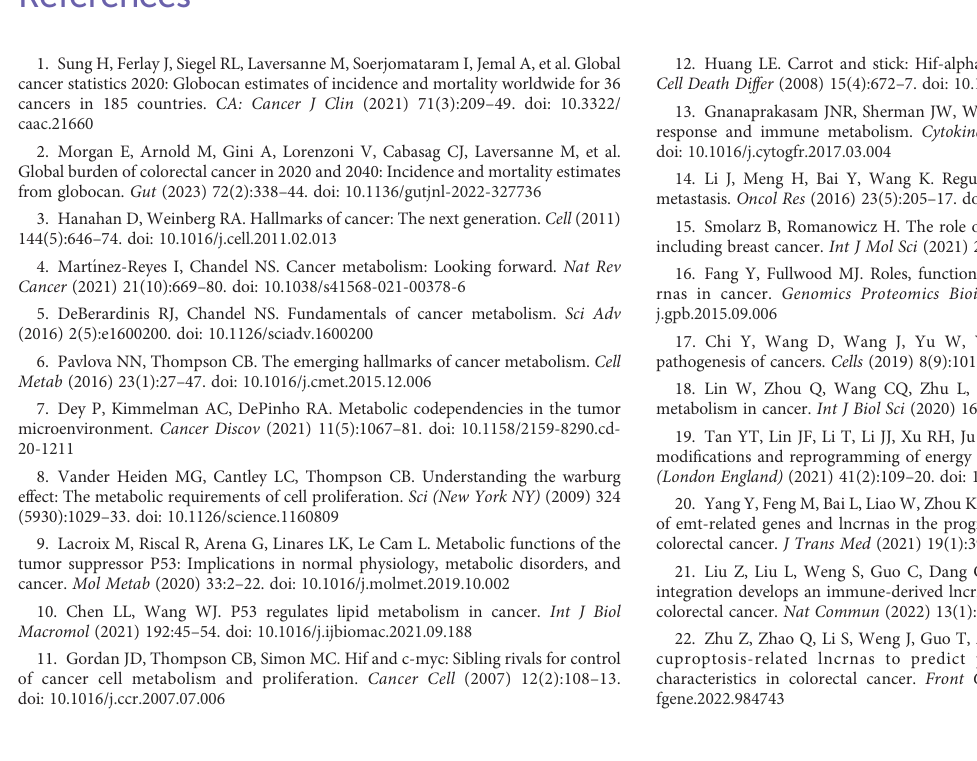
SUPPLEMENTARY FIGURE 1 Expression of hub lncRNA in CRC tissues. (A – C) Differential expression analysis of AC004846.1, AL391422.4 and UBA6-AS1 in CRC tissues and adjacent normal